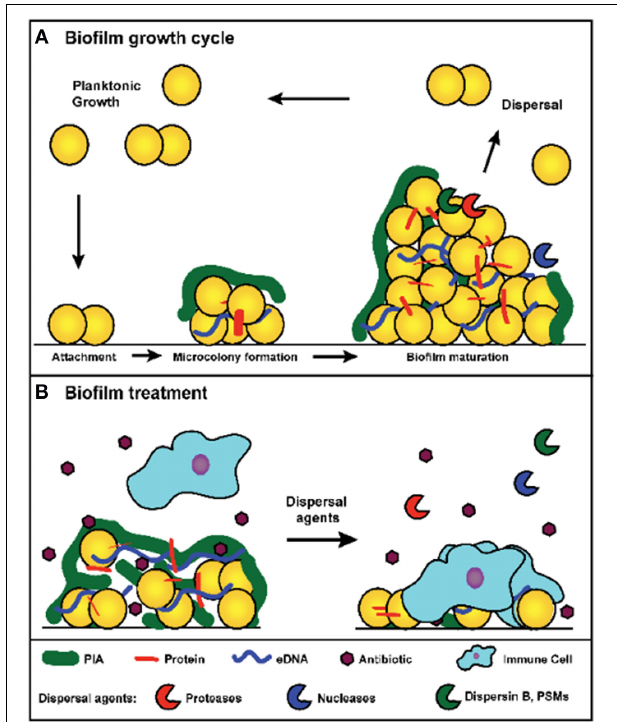
FIGURE 1 | (A) Model of S. aureus biofilm growth cycle. In summary, upon coming into contact with a surface, planktonic cells attach through surface-associated proteins. Following attachment, cells divide and begin production of the extracellular matrix, which leads to the formation of a microcolony. As cell division continues, biomass accumulates and a mature biofilm is formed. Environmental signals within the biofilm trigger the activation of dispersal mechanisms, and upon dispersal, cells re-enter a planktonic growth state and can seed new sites for biofilm formation. (B) Treatment of a S. aureus biofilm. Antibiotic exposure will kill susceptible planktonic cells and metabolically active cells near the surface of the biofilm. However, persister cells and metabolically dormant cells within the biofilm survive and remain protected from immune defenses by the biofilm matrix. Treatment with dispersal agents increases the effectiveness of antibiotic penetration and promotes clearance. Antibiotic sensitive cells within the biofilm are exposed and killed after degradation of the matrix, and the antibiotic tolerant cells (such as persisters) survive and are susceptible to the immune